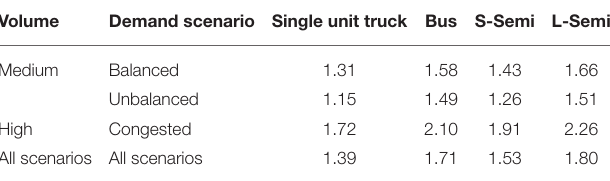
TABLE 4 | Estimated PCE values for three demand scenarios and all scenarios for Tanyel et al. method.